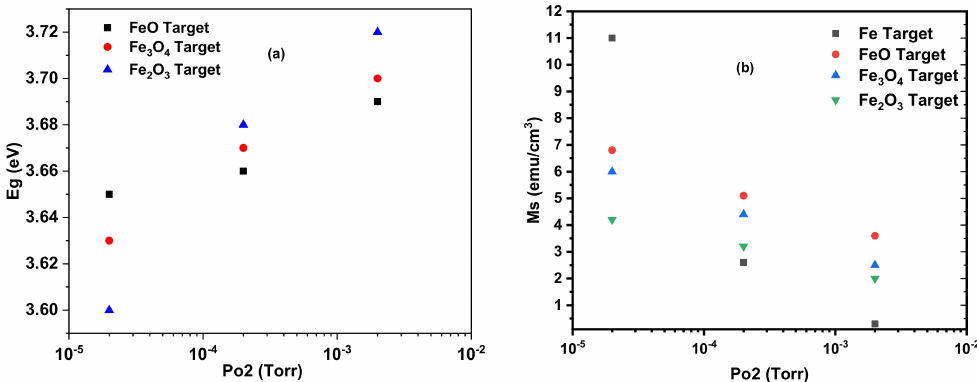
Figure 8. The dependence of ( a ) the band gap and ( b ) the saturation magnetisation on the oxygen